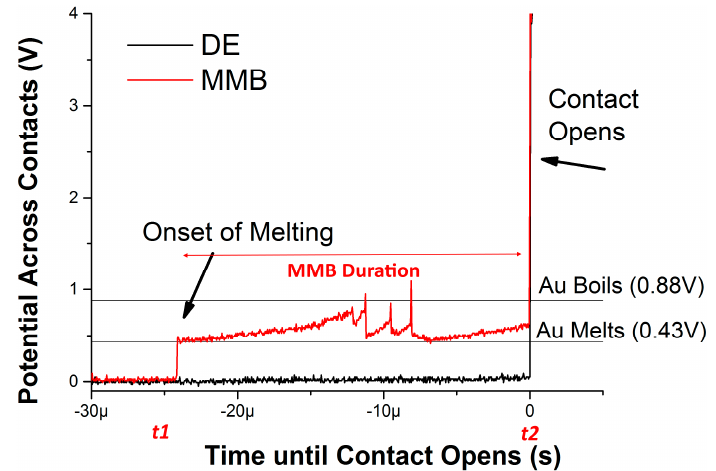
Figure 1. The contact potential during two hot switched opening events of a Au/MWCNT contact switched at 4 V and 20 mA. The red trace is characteristic of a molten metal bridge forming with steps linked to the melting and boiling voltages for Au. The black trace is characteristic of a delamination event (DE) that shows no evidence of the contact material melting or boiling.